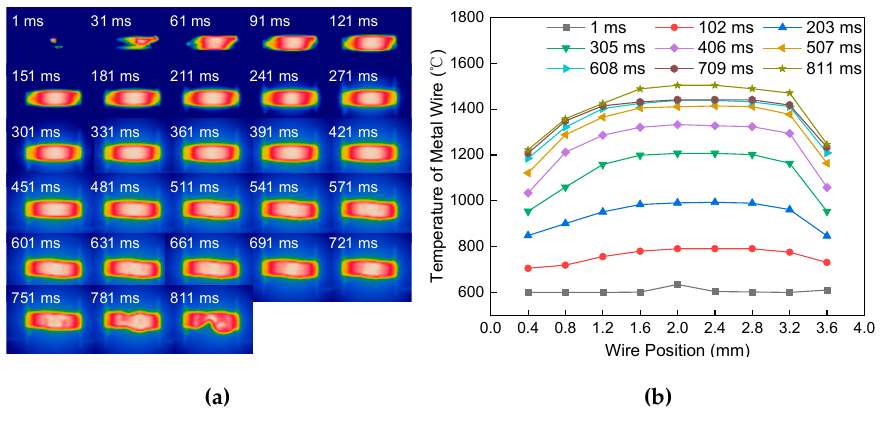
Figure 6. E ff ect of current on melting of a single metal wire. ( a ) Melting process. Figure 6. Effect of current on melting of a single metal wire. (a) Melting process. (b) Temperature ( b ) Temperature distribution.